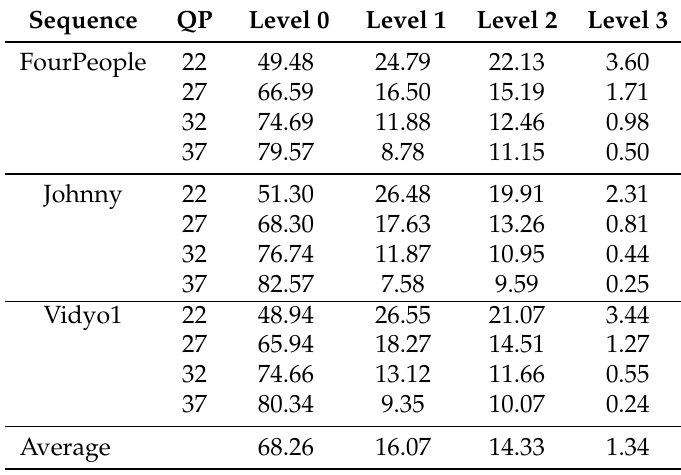
Table 1. Statistical results of the best CU quadtree depth level distribution (%). QP, quantization